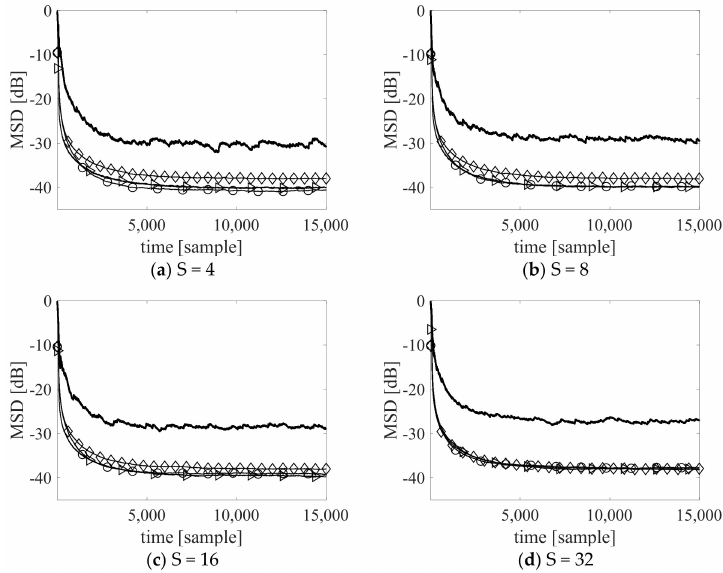
Figure 1. Steady state MSD for S = 4, 8, 16, 32 (- -: the proposed algorithm, - ◦ -: convex regularized (cid:3) recursive maximum correntropy (CR-RMC), - (cid:5) -: maximum correntropy criterion (MCC)- recursive least squares (RLS), solid line: conventional RLS without considering impulsive noise and sparsity): ( a ) S = 4, ( b ) S = 8, ( c ) S = 16, ( d ) S =